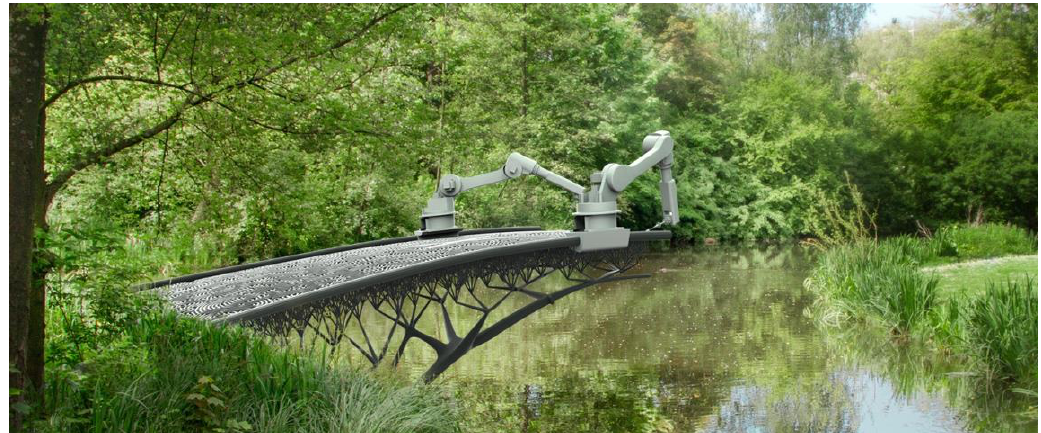
Figure 5. An impression of a 3d-printed bridge that artist and designer Joris Laarman's start-up company MX3D is planning to build in